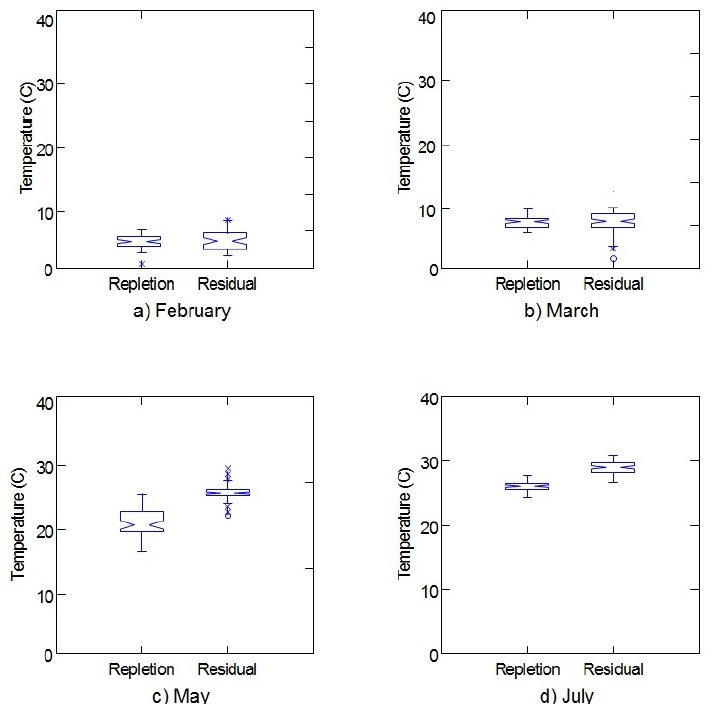
Figure 6. Box plots of ASTER-derived skin surface temperatures for flood repletion and residual lagoon water bodies ( a ) 19 February 2005, ( b ) 19 March 2006, ( c ) 23 May 2004, and ( d ) 3 July 2004.